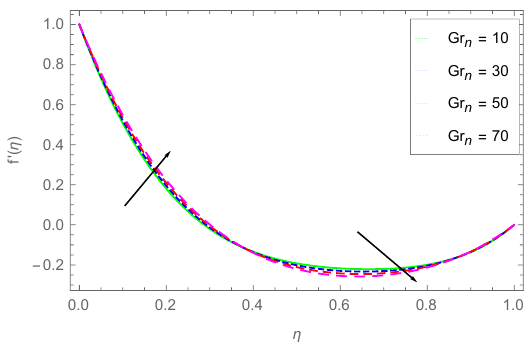
Figure 6. f (cid:48) ( η ) dependence on Gr . The effect of enhancing values of the rotation parameter kr on the hybrid nanofluid velocity f ( η ) is plotted in Figure 7. The values of kr were chosen as 1, 3, 5, 7. Figure shows that at a given value of kr , the fluid velocity first enhances, reaches the maximum, and then, drops with the rising η . The figure also displays that the augmenting kr causes the fluid velocity profile to drop. The rate of velocity drop decreases with the increasing kr as displayed by the decreasing separation between the velocity curves at higher values of kr . The different curves overlap at about η = 0.82. Thus, the enhancing rotation rate offers a higher constriction to the fluid velocity, which causes the fluid velocity to drop. Thus, the enhancing rotation rate associated with the higher values of kr saturates the velocity drop during the hybrid nanofluid